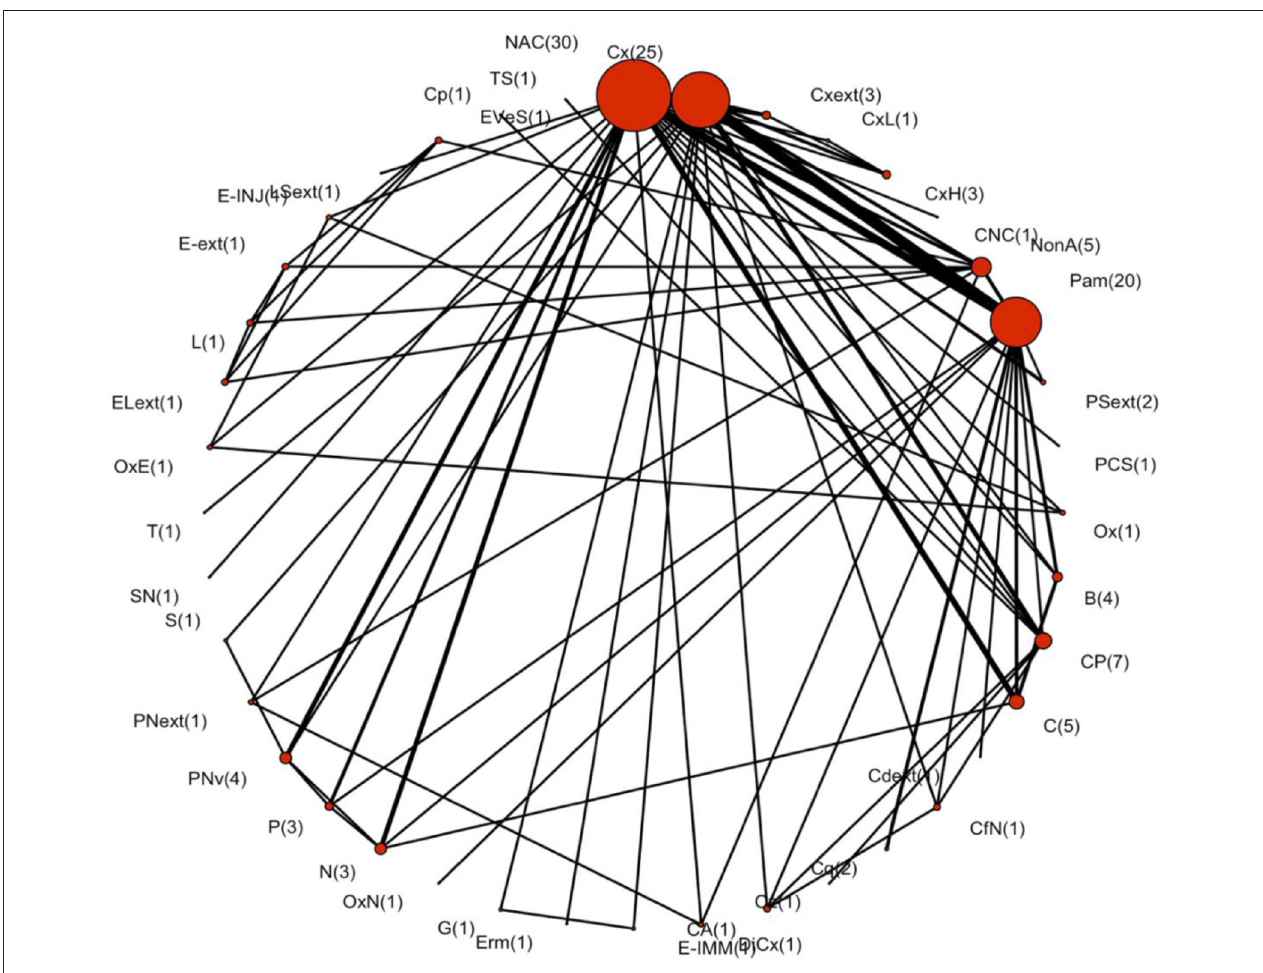
FIGURE 2 | Network plot assessing the efficacy of dry cow antimicrobials, non-antimicrobial products, or placebos for the all-cause cure of intramammary infections during the dry period in dairy cattle. This plot contains 58 trials, with the number of treatment comparisons provided in parentheses. Non-active control had the most treatment comparisons (30 arms). Node size represents the number of times each treatment was used. Edge size represents the number of direct comparisons made between the two treatment protocols. The definitions of treatment acronyms are available in Table 2 .